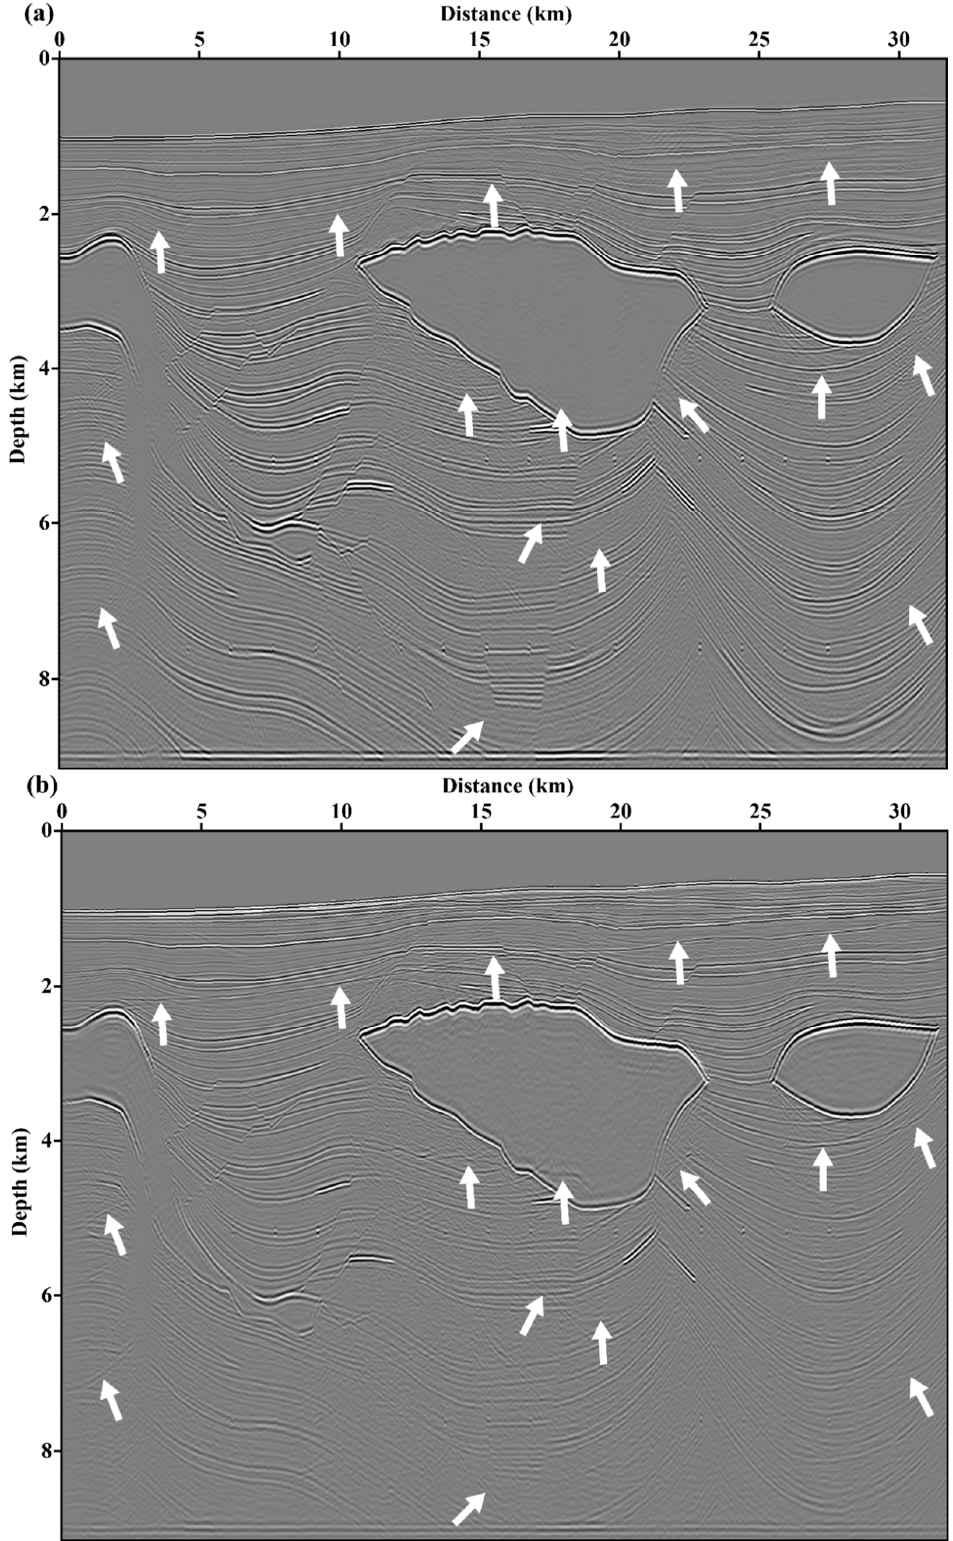
Figure 9. ( a ) The LSRTM (six iterations) image and ( b ) the LSRTMM (six iterations) image.